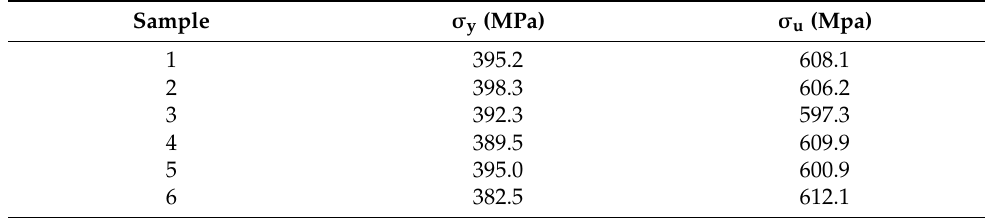
Table 1. Results of the tensile